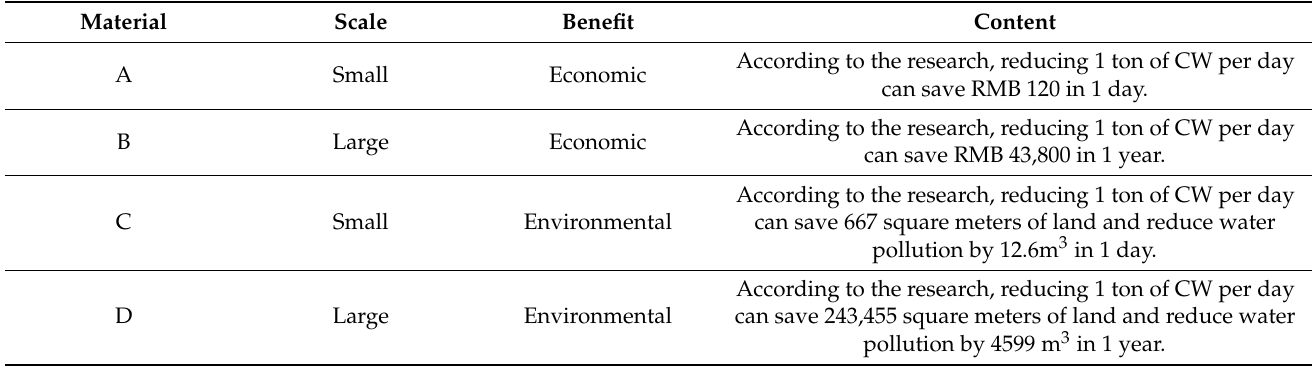
Table 1. The four scenarios regarding scale and benefit messages in the experiment.